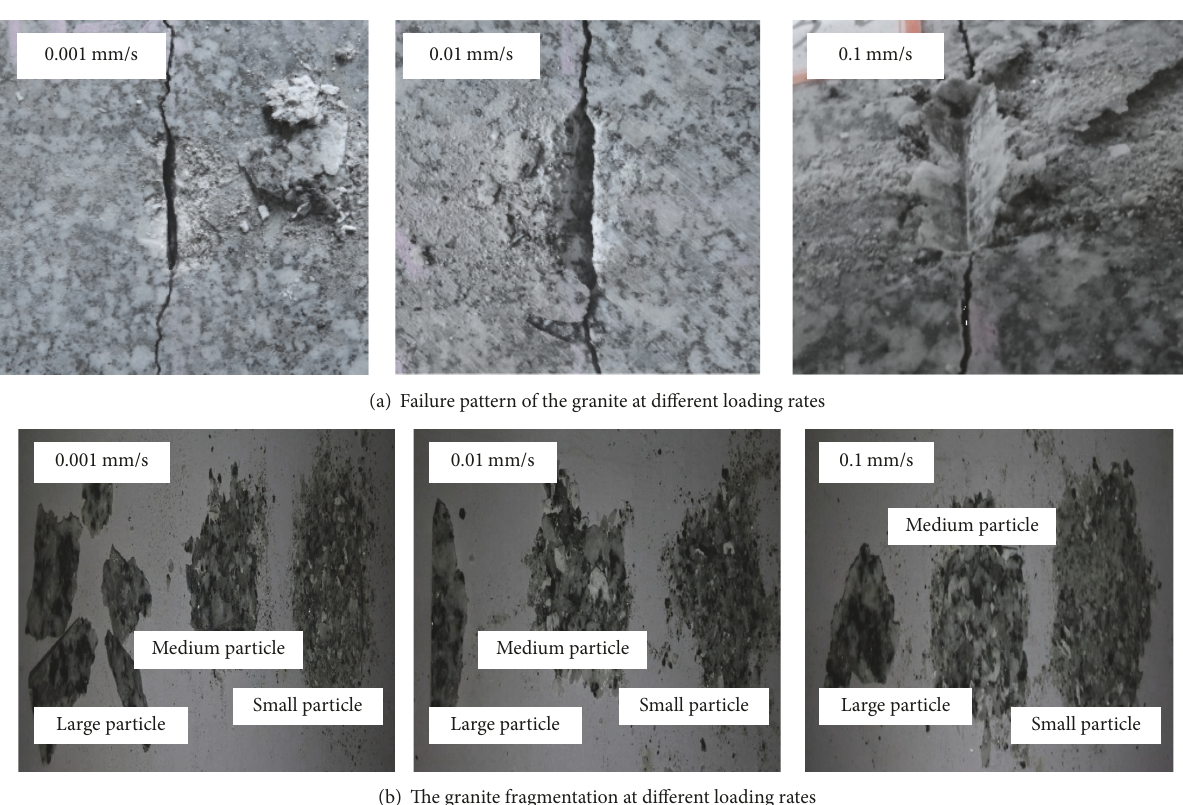
Figure 4: Failure characteristics of the granite at different loading